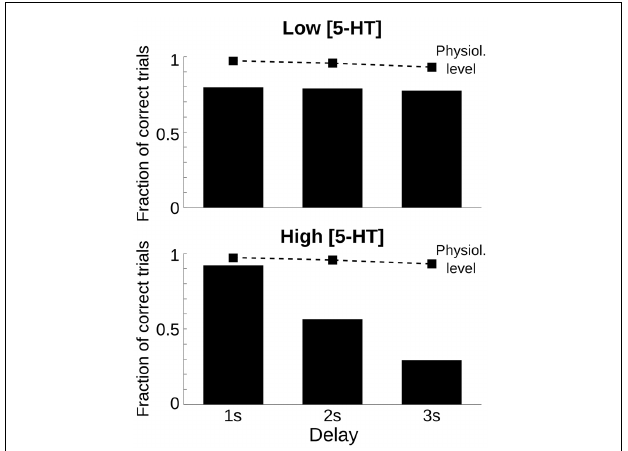
FIGURE 3 | Only high 5-HT effects on SWM performance depend on delay length. Fraction of correct trials, from a total of 1000 simulation trials, for a delay length of 1, 2, and 3s for two levels of [5-HT], compared with the physiological level of [5-HT] (dashed line). Top , for a low level of [5-HT] (20% reduction compared to the physiological level), the fraction of correct trials was reduced but remained roughly constant for different delay lengths. Bottom , for a high level of [5-HT] (20% increase compared to the physiological level), the fraction of correct trials diminished parametrically with increasing delay length.